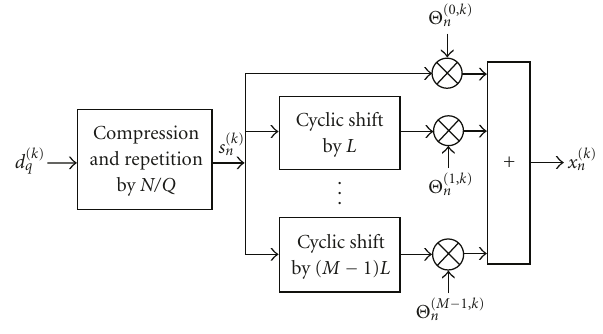
Figure 15: B-IFDMA time domain